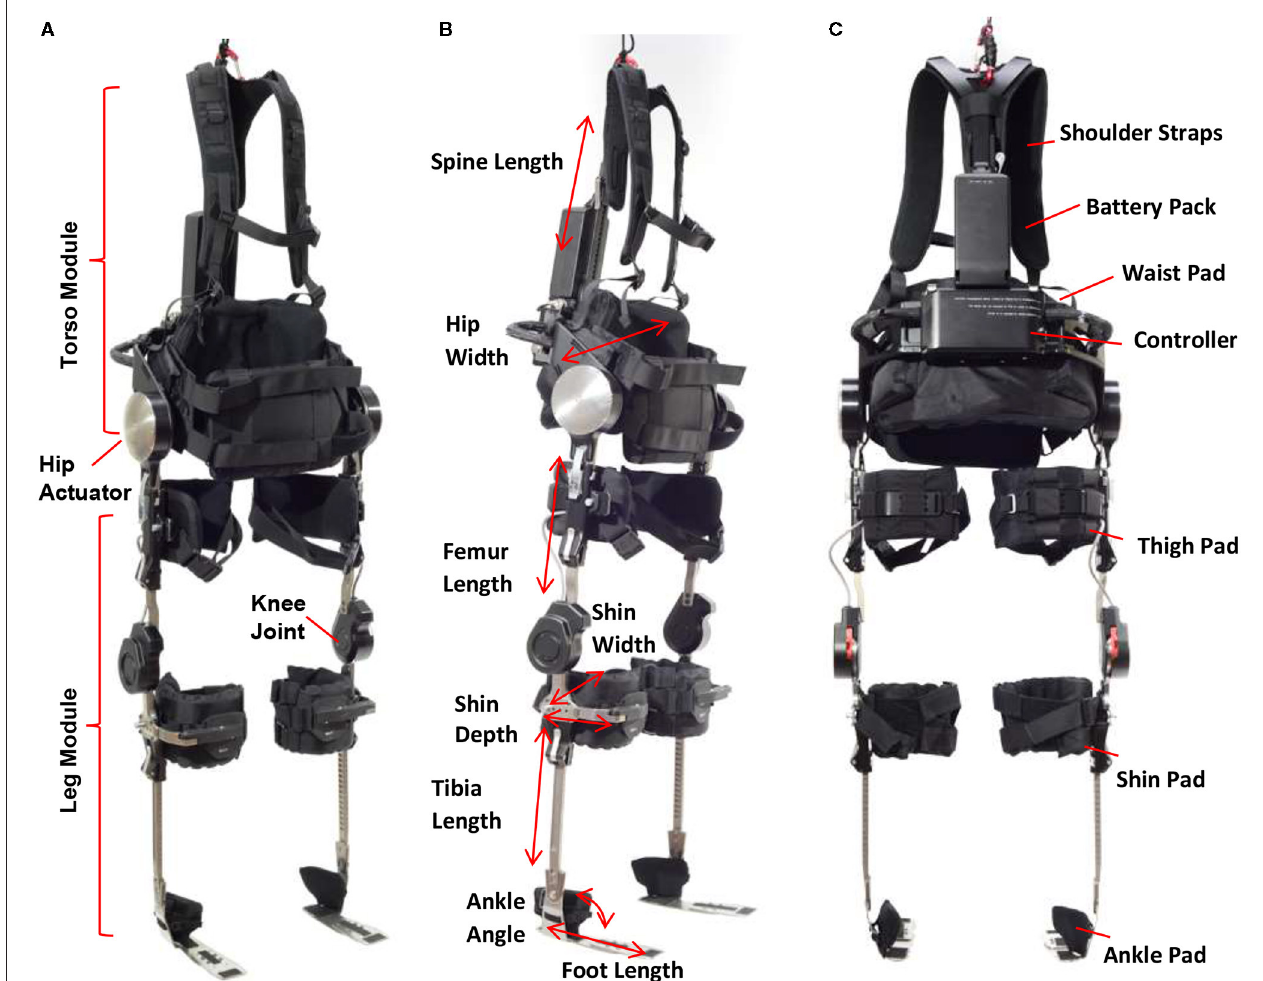
FIGURE 1 | (A) Phoenix modules, (B) adjustments, (C) padding and